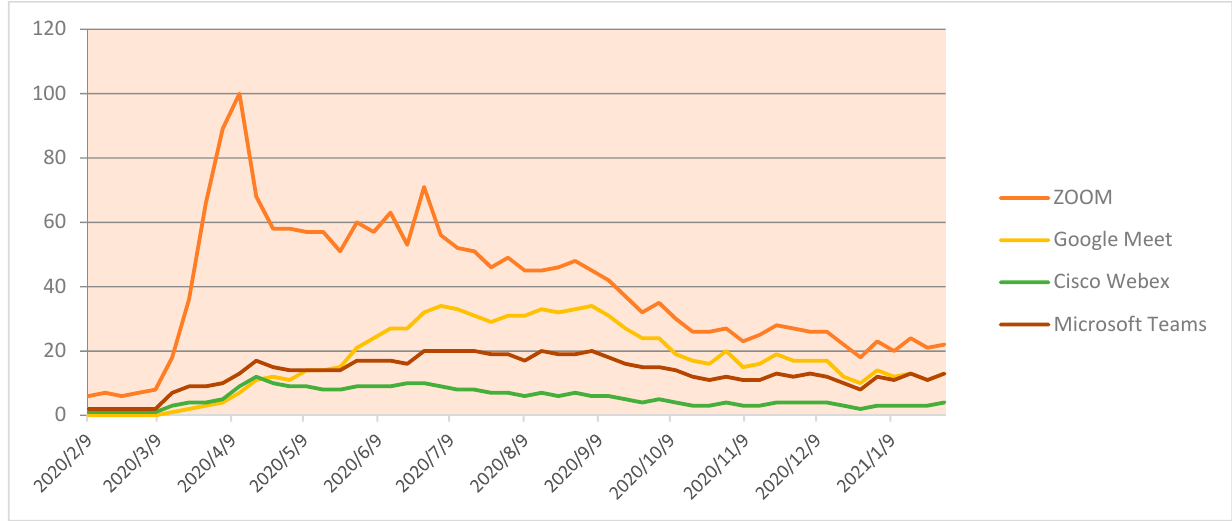
Figure 3. Comparison of different online platforms.